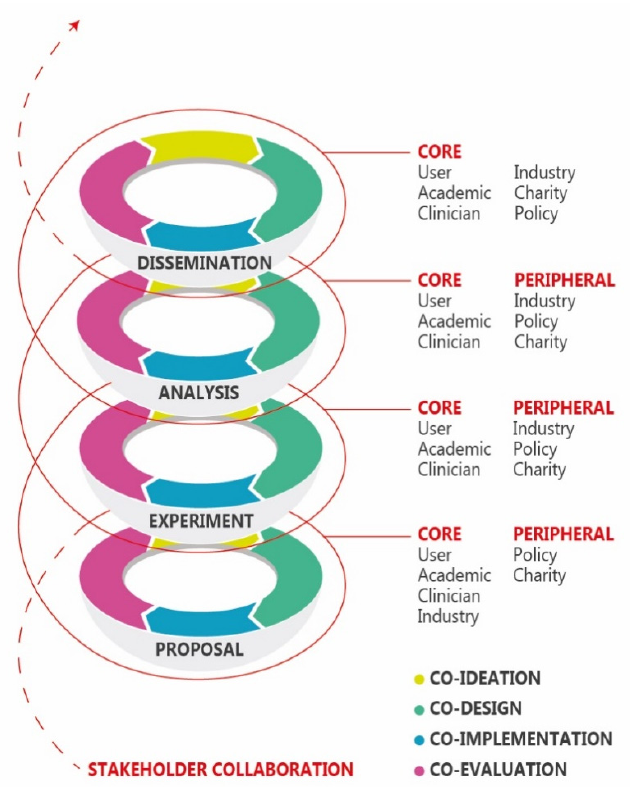
Figure 2. Co-creation model for upper limb prosthetics.